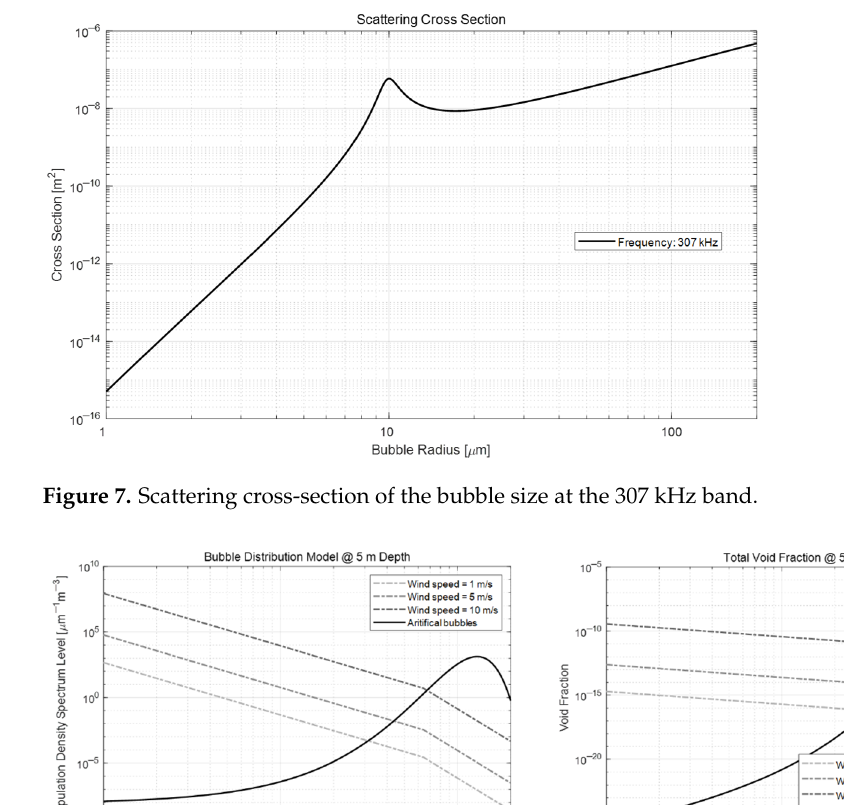
Figure 7. Scattering cross-section of the bubble size at the 307 kHz band.